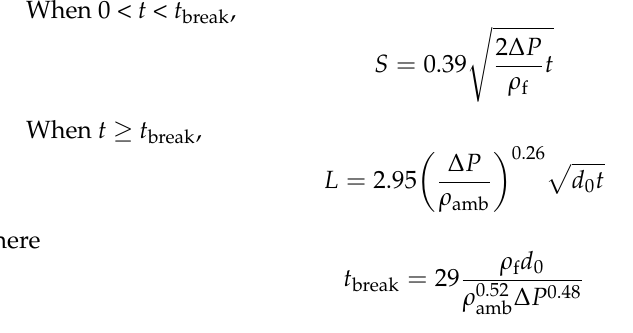
amb = 1 MPa, (b) P amb = 2